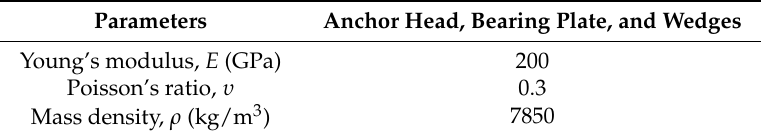
Table 1. Material properties of anchorage components.